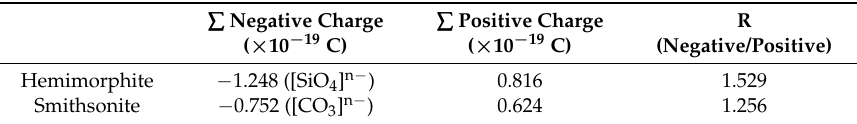
Table 5. Charges on the hemimorphite (110) surface and smithsonite (101)